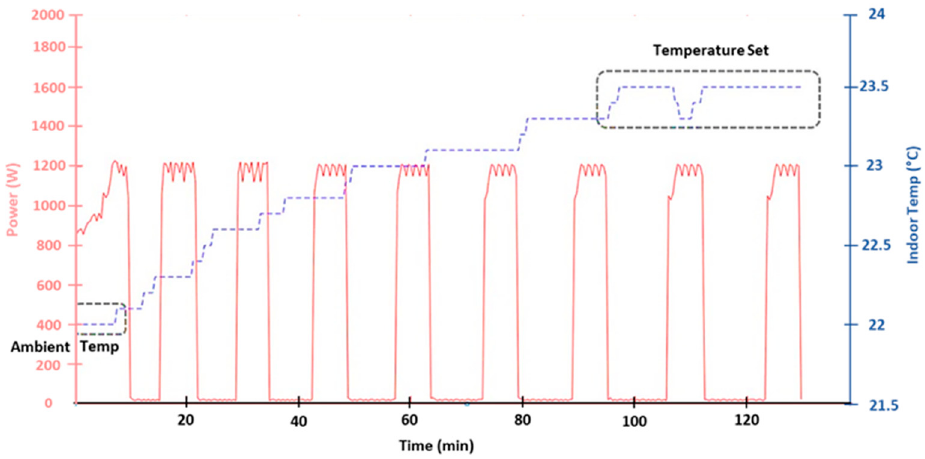
Figure 13. HVAC 2 h consumption profile.